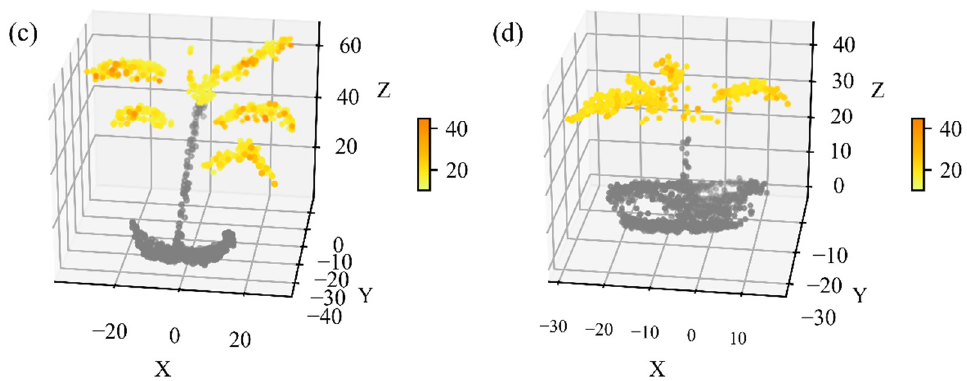
Figure 10. The 3D distribution of ( a , b ) elevation and ( c , d ) V cmax of two potted maize plants. The units of elevation and V cmax